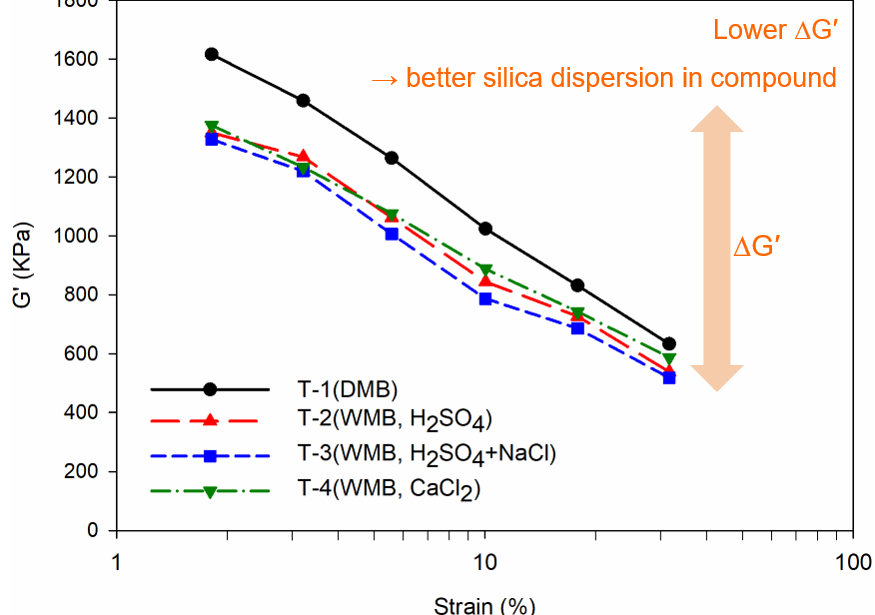
Figure 3 . Payne effect (Δ G ′) of the T-1 to T-4 compounds, which mean degree of filler dispersion in a compound: the black line graph is the Payne effect result of the T-1 DMB compound, the red line is the Payne effect result of the T-2 WMB compound, the blue line is the Payne effect result of the T-3 WMB compound, and the green line is the Payne effect result of the T-4 WMB compound.